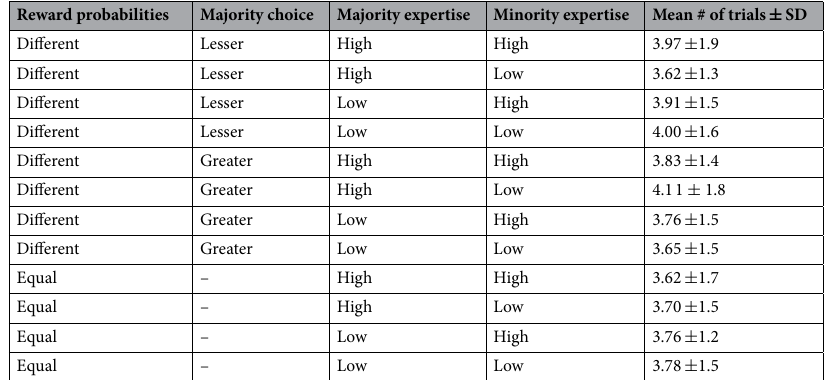
Table 1. Combination of reward and expertise variables into 12 within-subject conditions. The 2nd column indicates whether the majority of ostensible previous gamblers selected the option with a lesser or greater reward probability. Two additional conditions, for which ostensible previous gamblers where evenly divided across options (i.e., now majority) were included in the study but not listed in the table (see